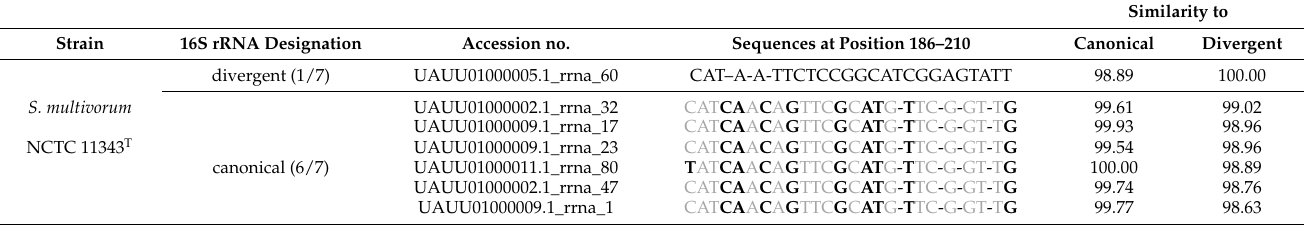
Table 2. 16S rRNA gene sequence similarity within Sphingobacterium multivorum NCTC 11343 T .